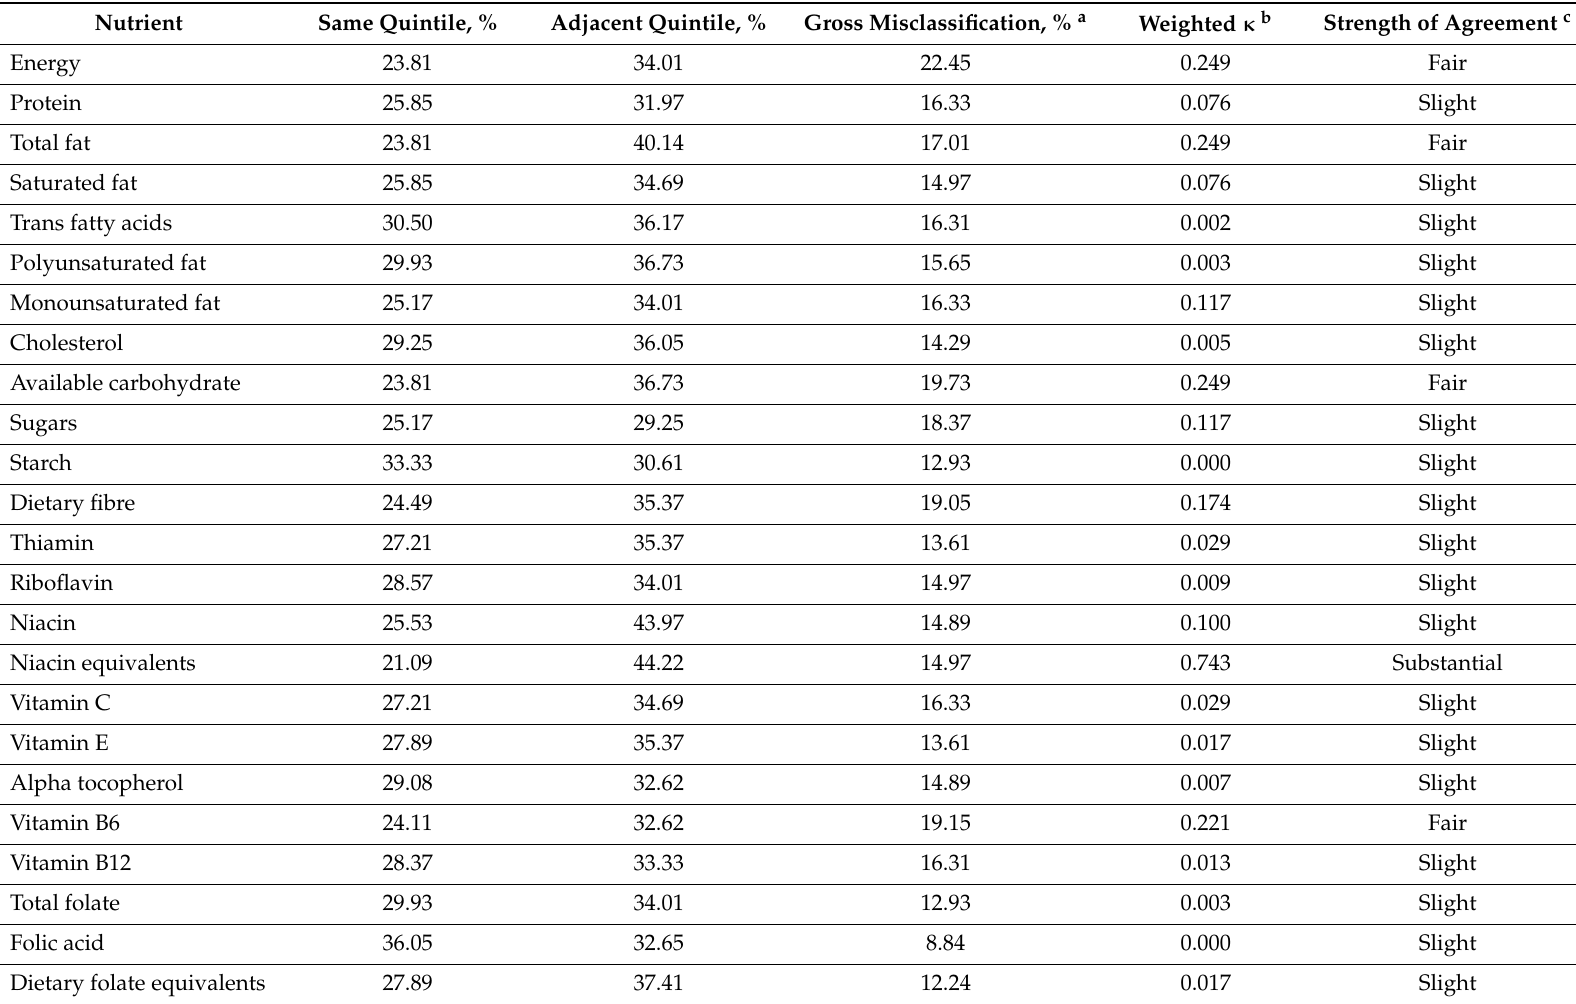
Table 3. Quintile percentage agreement between energy and nutrient intakes determined from the Alzheimer’s disease-CSIRO Food Frequency Questionnaire and four-day weighed food